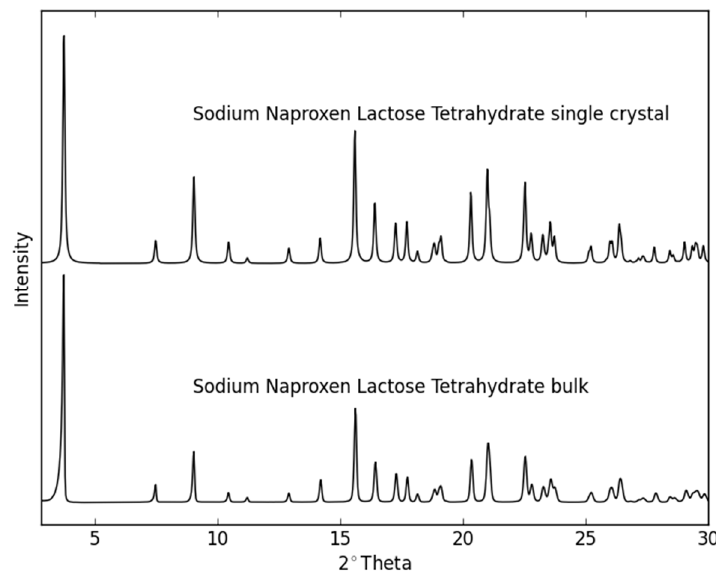
Figure 3. The powder diffraction pattern simulated from the NaN-Lact-4H 2 O co-crystal structure and the experimentally-determined XRPD diffractogram of the bulk material.